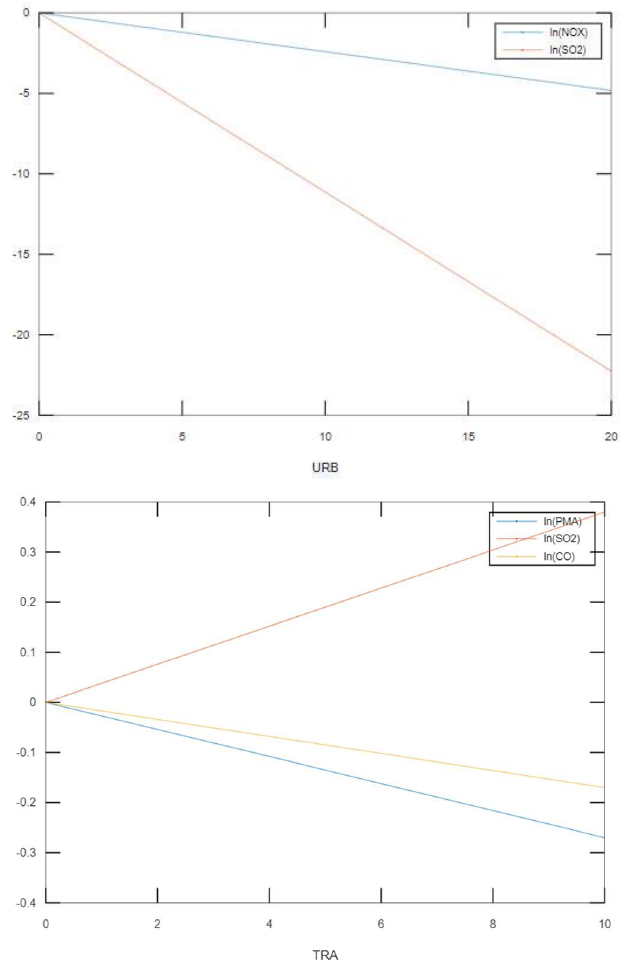
Figure 1. Graphical Summary of Results.